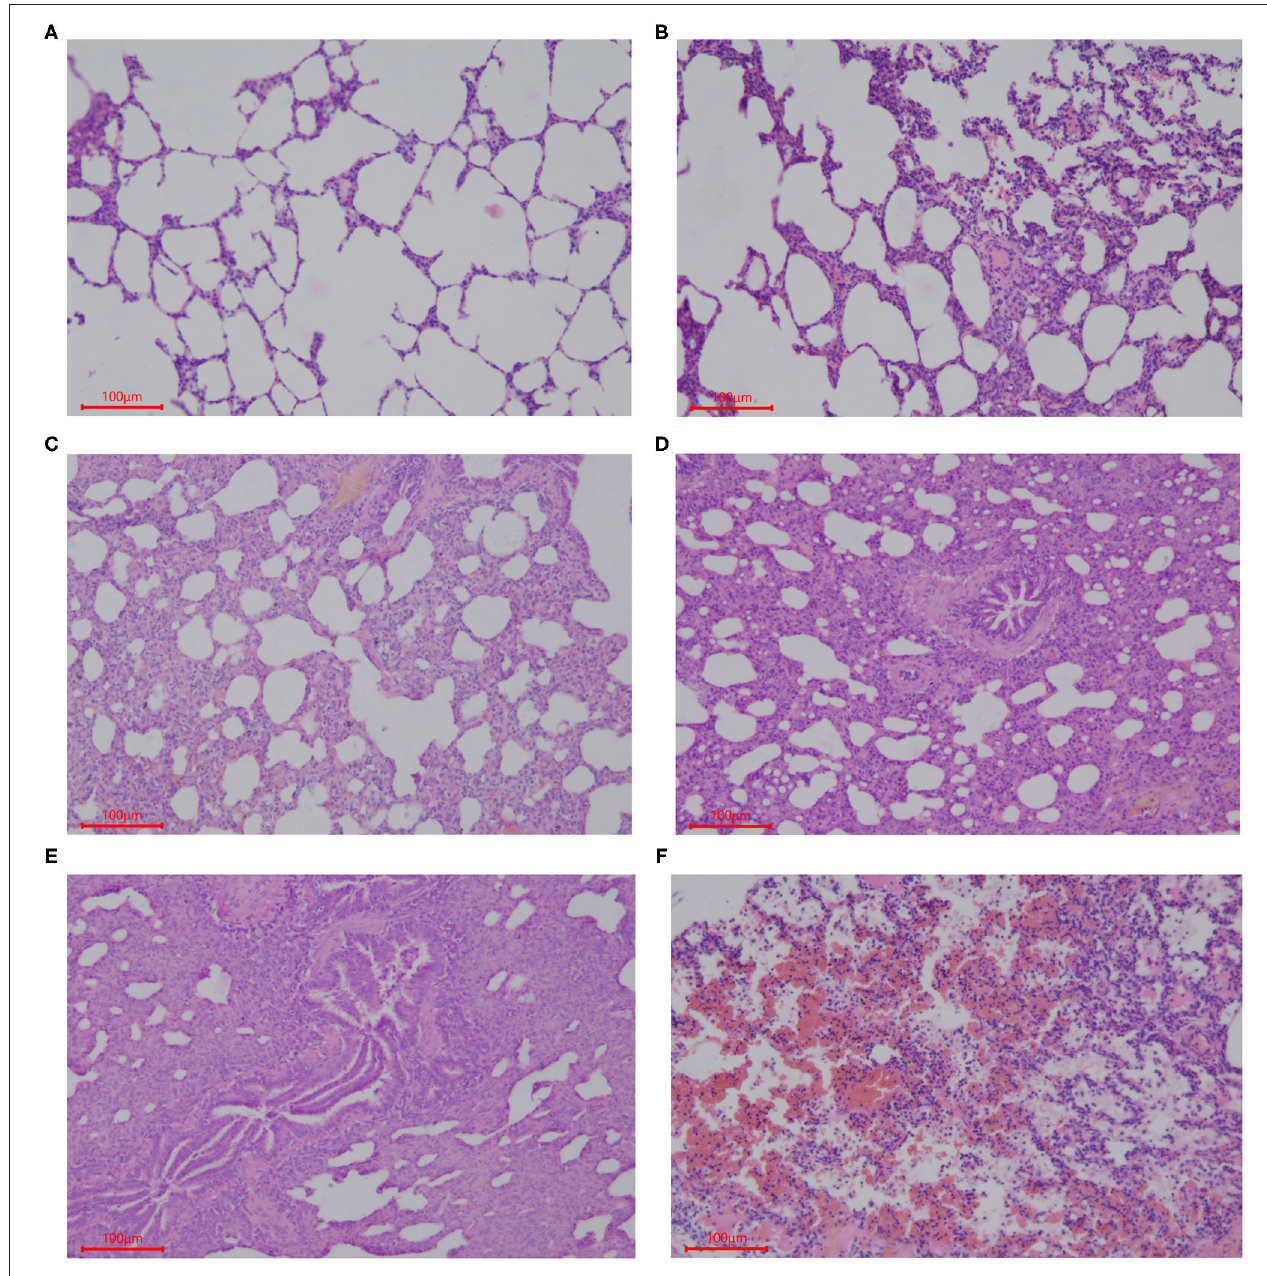
FIGURE 1 | Scoring criteria of lung pathological damage after CFA challenge. The lung injury of piglets in each group was graded by the following description: (A) 1, normal lung tissue structure, thin and non-proliferating alveolar wall, focal hyperplasia, unconnected hyperplastic nodules, and no exudate or red blood cells in the alveolar cavity; (B) 2, with pulmonary interstitial hyperplasia, presence of two ocal nodular hyperplasia, the nodules connected by proliferated alveolar septal, with local alveolar wall Telangiectasia congestion or congestion, and the presence of red blood cells in alveolar cavity; (C) 3, mild pulmonary interstitial hyperplasia, diffuse and widening alveolar septum with a small amount of inflammatory cell infiltration, narrow alveolar space; (D) 4, moderate hyperplasia of the interstitium, reduced number of alveoli, severe stenosis in the alveolar cavity accompanied by a large number of inflammatory cells; (E) 5, severe pulmonary interstitial hyperplasia and fusion, large areas of alveolar stenosis or disappearance accompanied by a large number of inflammatory cells; (F) 6, destruction of lung tissue, severe pulmonary hemorrhage, large numbers of red blood cells and serous exudate in the alveolar cavity and diffuse infiltration of a large number of inflammatory cells.